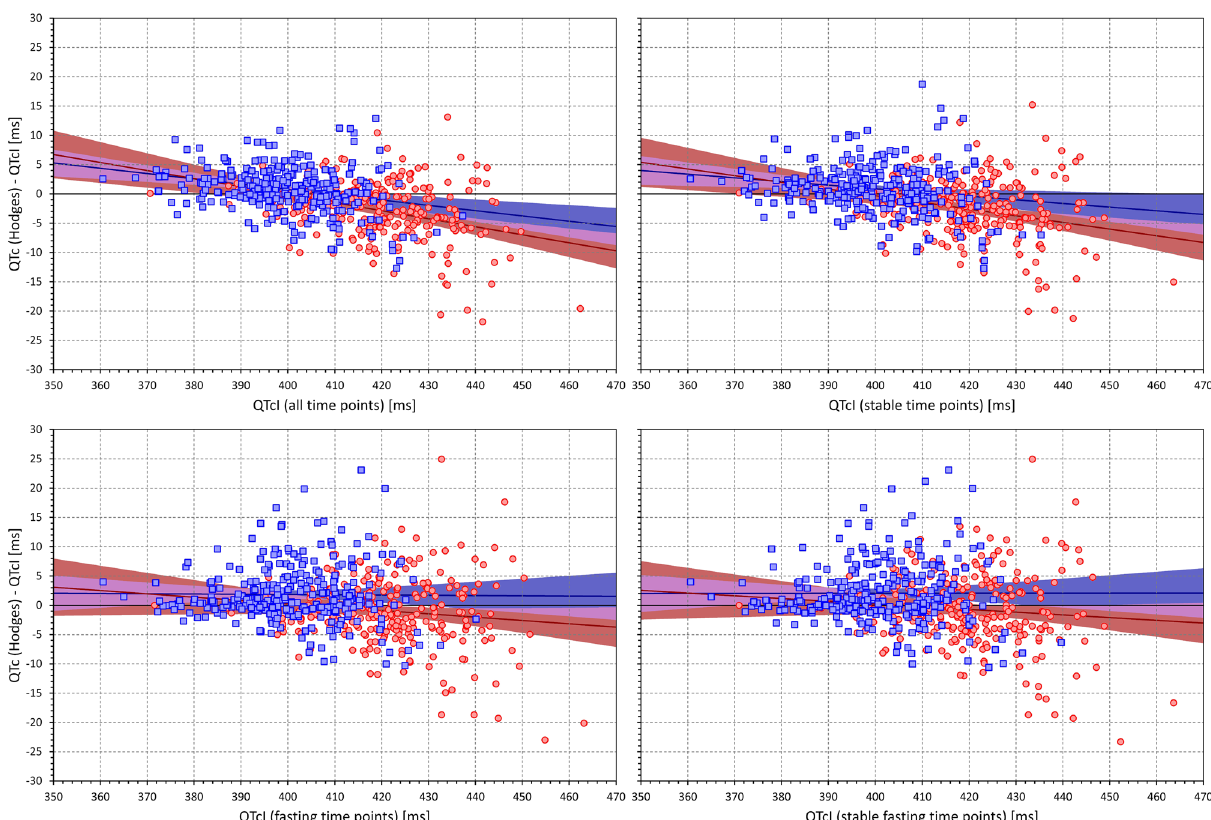
Figure 16. The figure meaning and layout correspond to those of Fig. 12 but instead Bazett QTc data, Hodges QTc data were